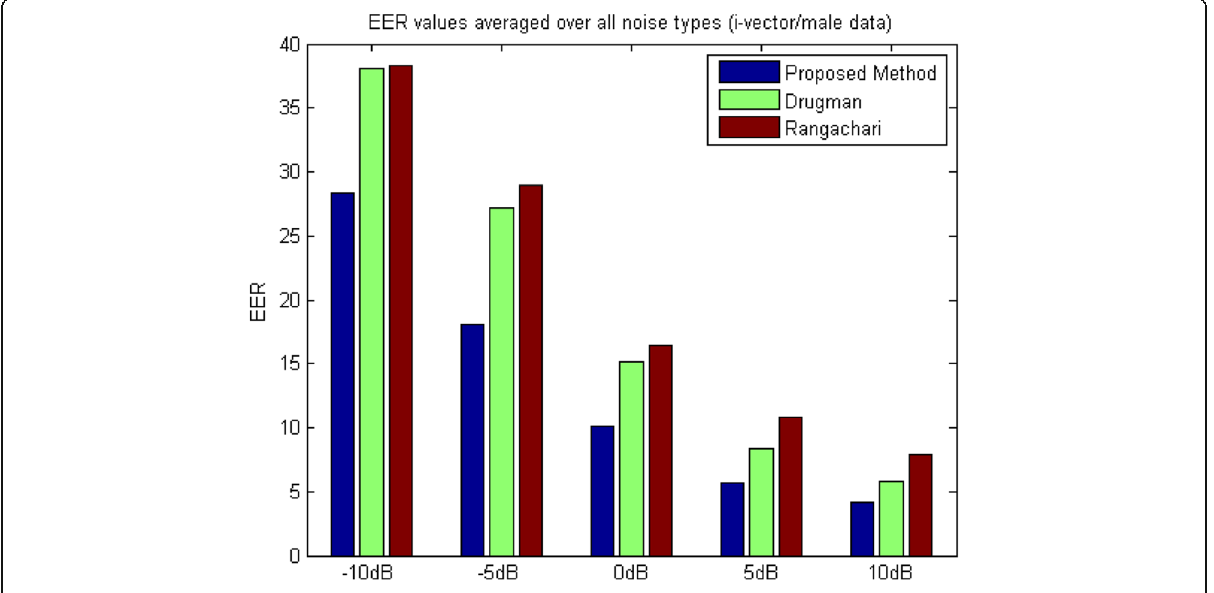
Fig. 9 EER values averaged over all noise types for the female data with i-vector backend